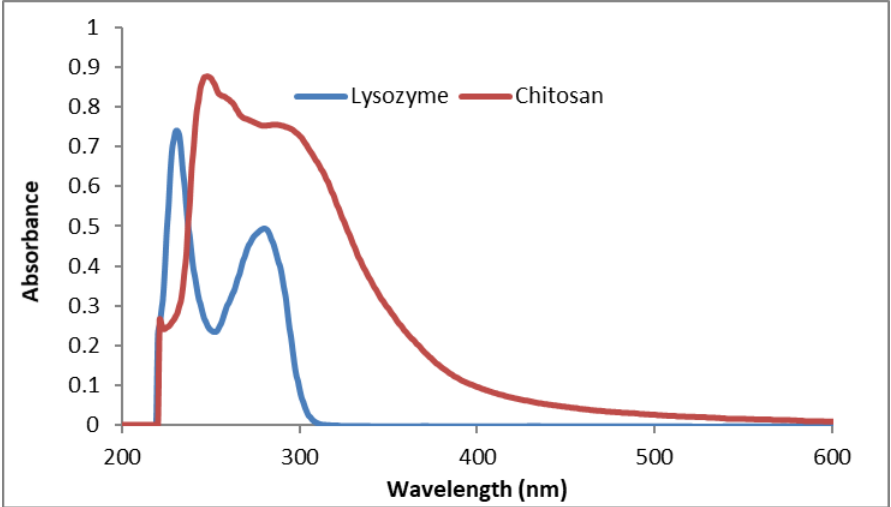
Figure 8. UV-VIS spectra of CS solution (1.0% w/v ) in acetic acid (1% v/v ) and lysozyme solution (0.2 mg/mL) in PBS (pH 7.4).